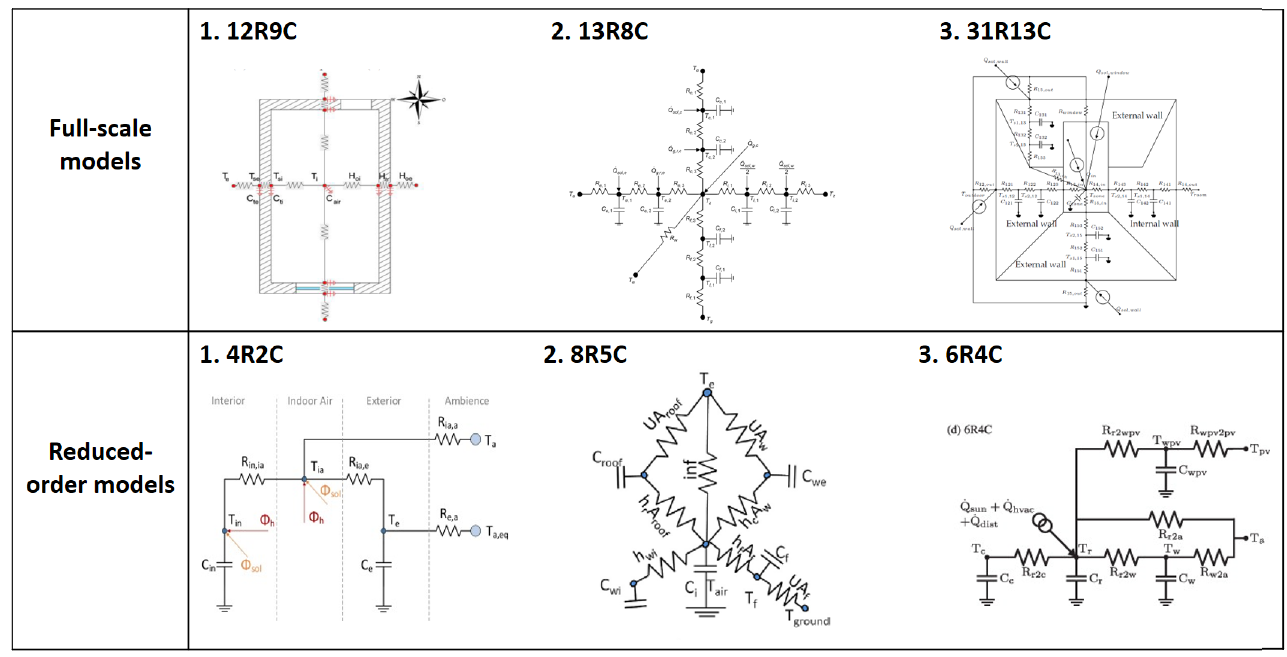
Figure 7. Few examples of full-scale models and reduced-order models Reproduced from: Boodi et al. [27], Braun and Chaturvedi [38], Harb et al. [86], Danza et al. [87], Reynders et al. [88], and Fux et al.